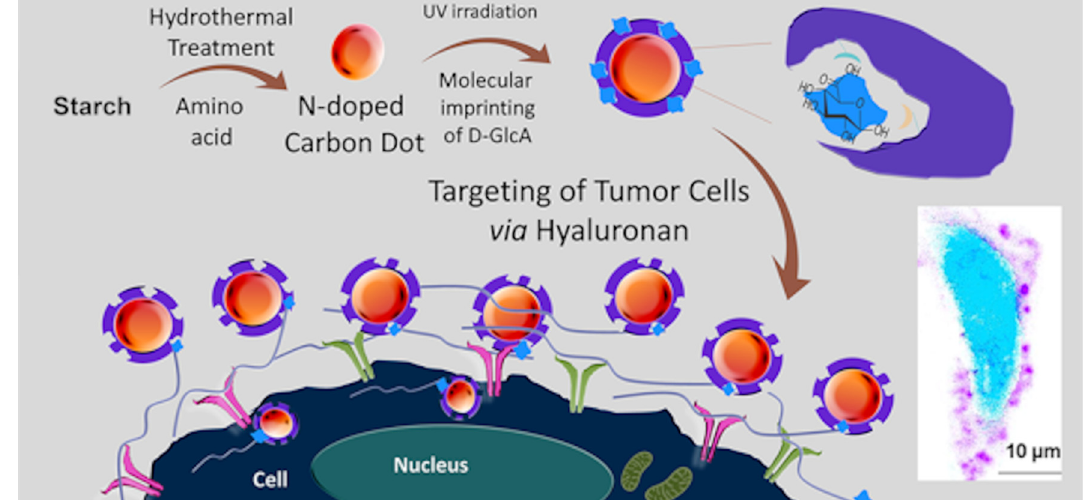
Figure 11. Preparation of core–shell CD-MIPs for bioimaging of cancer cells. Reprinted (adapted) with permission from Demir, B.; Lemberger, M.M.; Panagiotopoulou, M.; Medina Rangel, P.X.; Timur, S.; Hirsch, T.; Tse Sum Bui, B; Wegener, J.; Haupt, K. ACS Appl. Mater. Interfaces 2018 , 10, 3305 − 3313 [110]. Copyright 2018 American Chemical Society.